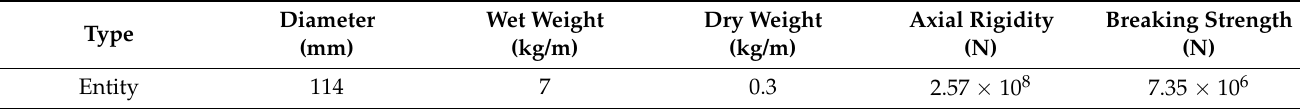
Figure 8. Numerical wave tank. ( a ) Computational domain. ( b ) Boundary condition. Table 6. Parameter of mooring line.